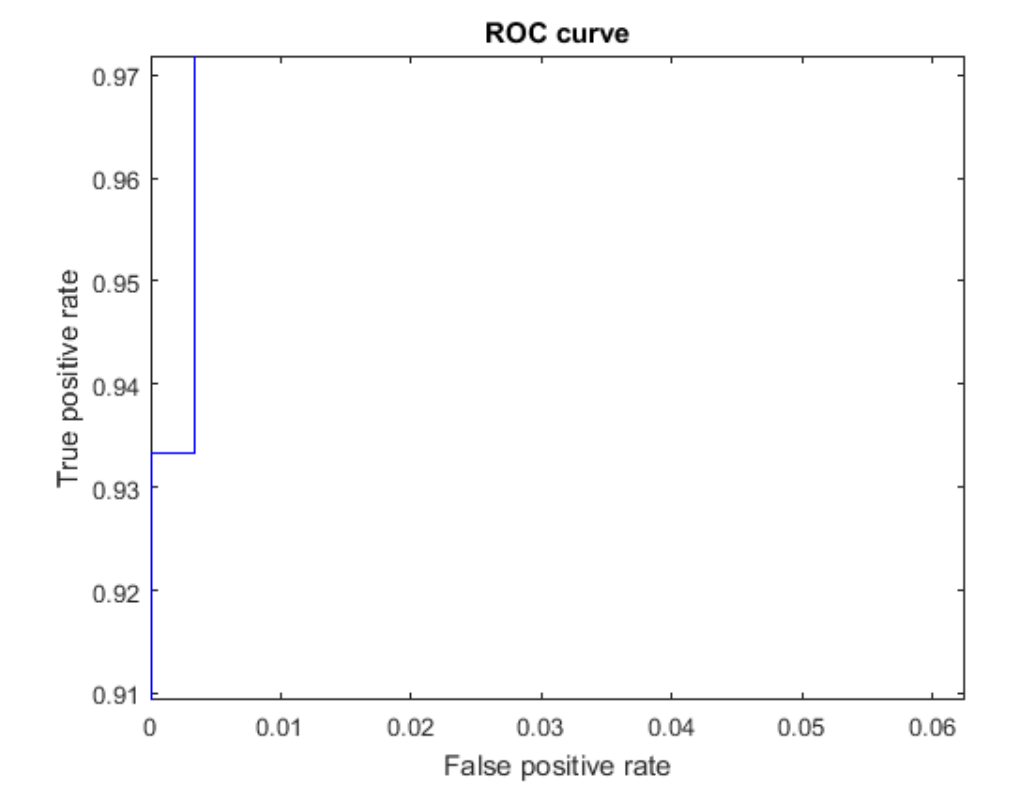
Figure 17. ROC curve for the letter V using Cartesian features, AUC = 0.9998. The number of FNs for each letter and person, corresponding to the confusion matrix of Cartesian features (Figure 12), can be seen in Table 6. Table 6. Number of false negatives (FN) by letter and by person, for the confusion matrix of the Cartesian features in Figure 12. Rows show the test letters, and columns show the test signers. For instance, Table(B,11) = U means that for letter B and signer 11, a false negative was generated (where B was confused with U). The last column ∑ shows the total number of false negatives by letter, and the last row ∑ shows the total number of false negatives generated by each